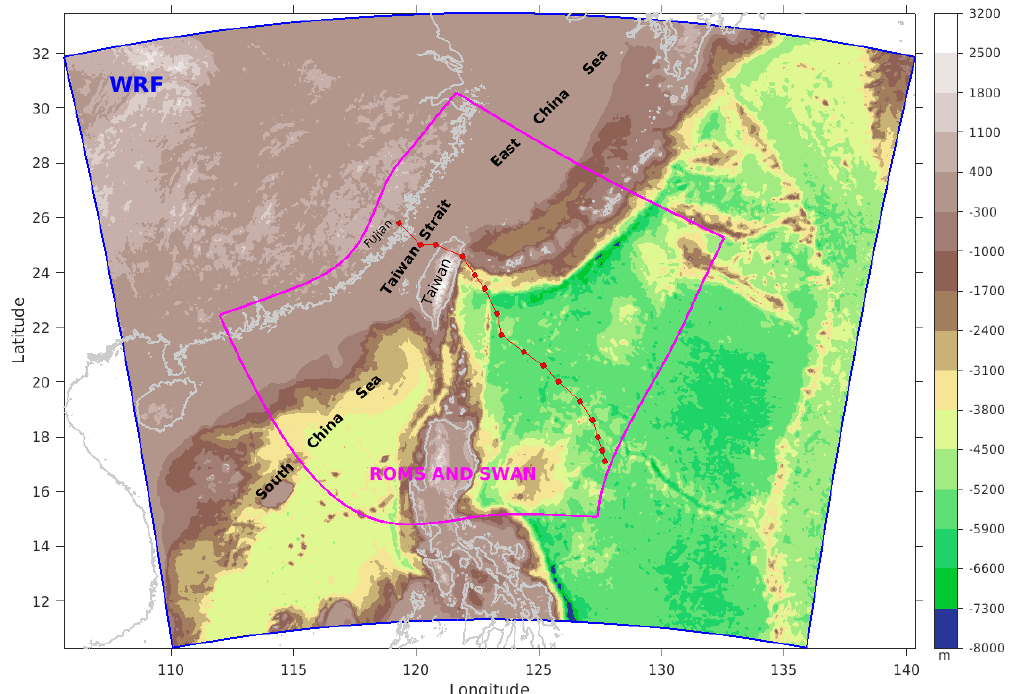
Figure 1. Location map showing the track (red squares) at six hour intervals of Typhoon Nesat (2017). Model domain for the Regional Ocean Modelling System (ROMS) and Simulating Waves Nearshore (SWAN) is bounded by pink curves, the domain for Weather Research and Forecasting (WRF) is shown in blue. Colour scale represents the bathymetry of the ocean and land topography height.